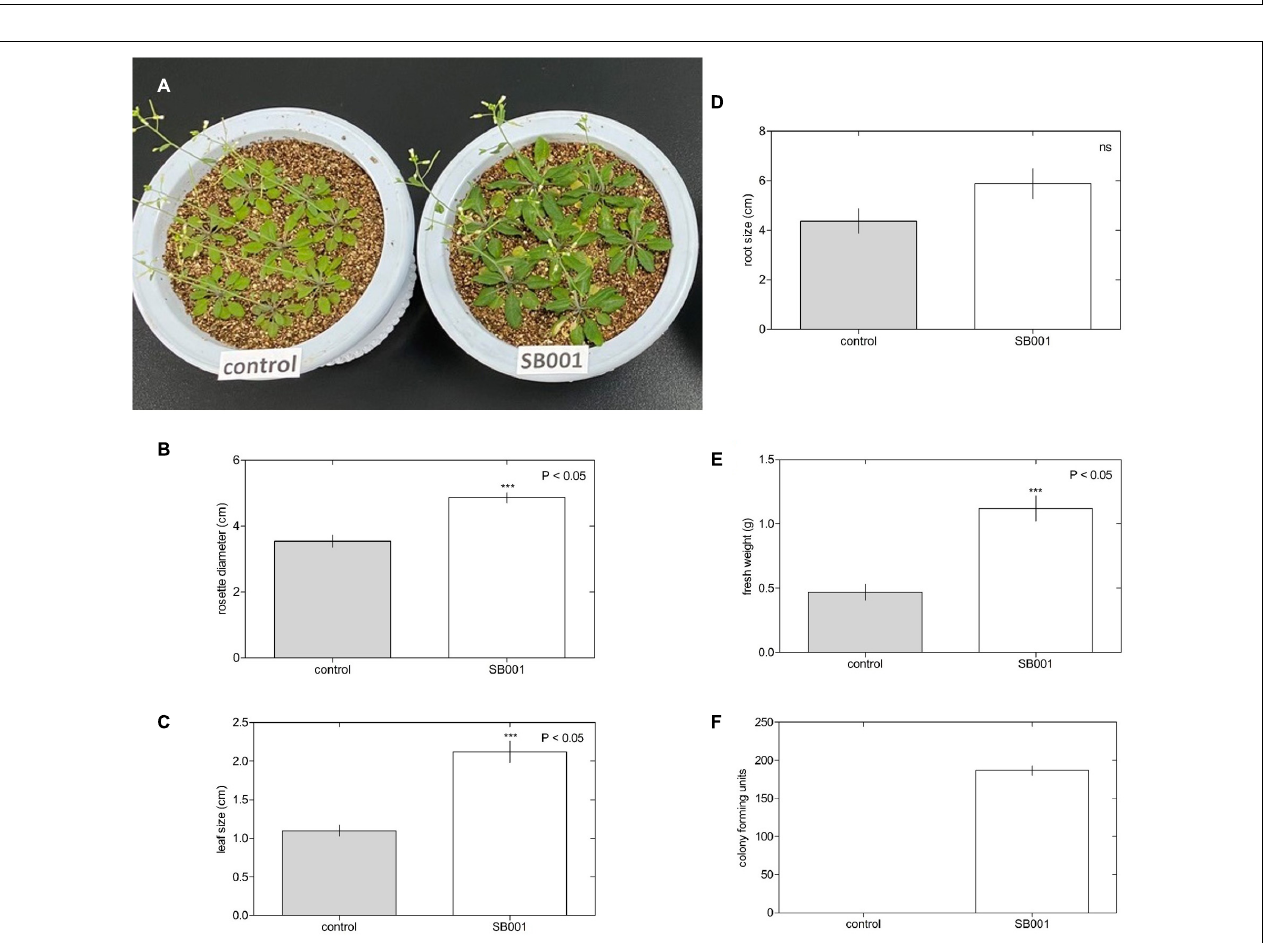
FIGURE 2 | Endophytic bacterium B. altitudinis induces significant Arabidopsis plant growth. Plants (5-day-old) were mock-treated (control) or inoculated with 30 ml of B. altitudinis at 4.77 × 10 9 CFU/ml. (A) Phenotype of Arabidopsis plants mock-treated (control) and treated with B. altitudinis fermentations (SB001) at 20 days post-inoculation. Effect on the rosette diameter (B) , leaf size (C) , root size (D) , and fresh weight (E) of Arabidopsis plants treated with B. altitudinis fermentations (SB001). (F) Colony-forming units were determined in Arabidopsis plants mock-treated (control) and treated with B. altitudinis fermentations (SB001). Each bar represents mean values with standard errors of two independent experiments ( n = 10). *** P ≤ 0.001.